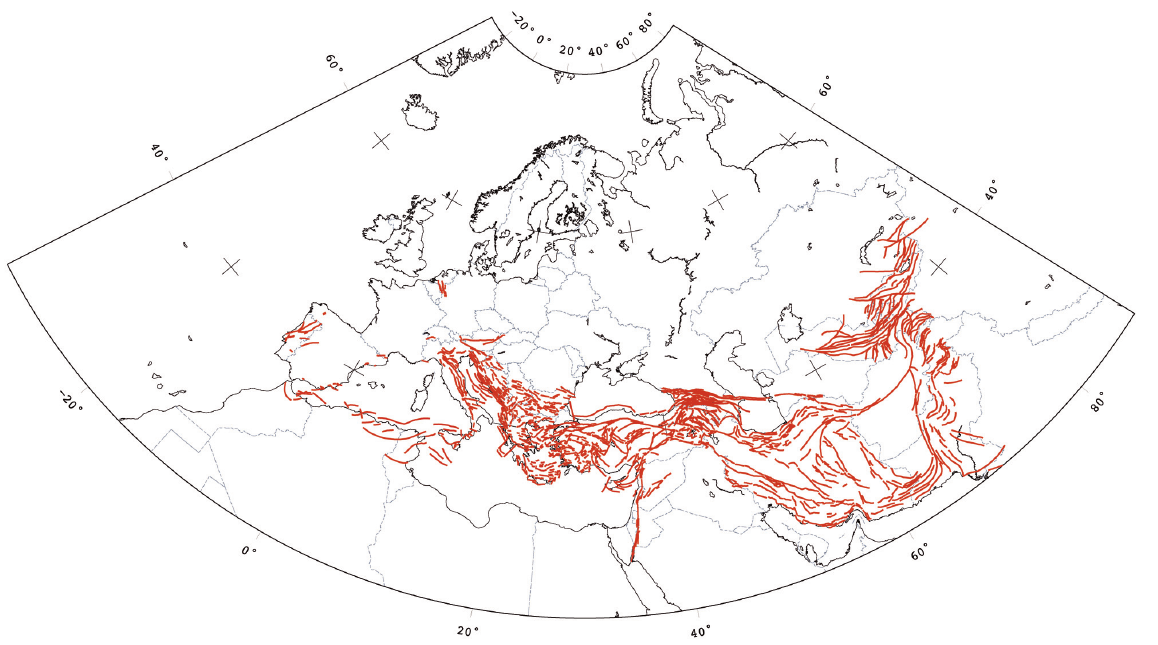
Figure 2. Unified crustal active faults for the entire region as compiled through successive harmonization procedures within ESHM13, EMM14 and EMCA.